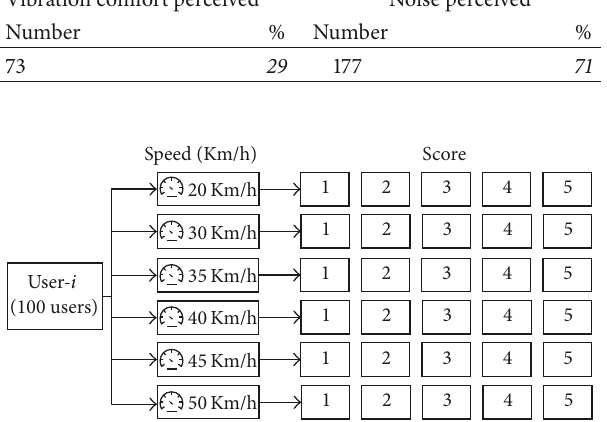
Table 3: Sample survey results on public transport vehicle to identify the weights 𝛼 𝑛 and 𝛼 V . Vibration comfort perceived